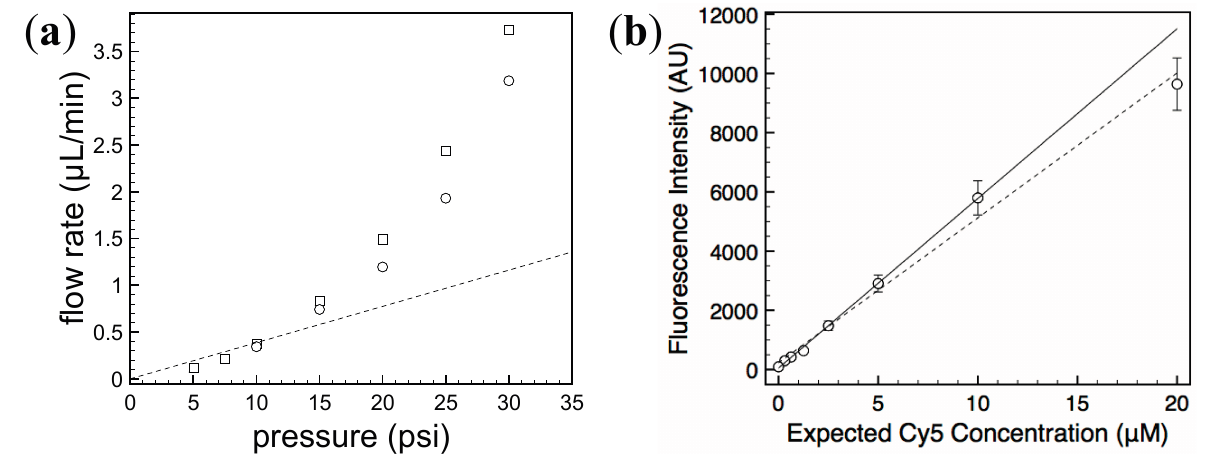
Figure 2. ( a ) Flow rates achieved by different injection methods: pressure controller ( □ ) and syringe compression ( ○ ). The microchannel used for this measurement had a dimension of 24 mm × 70 μ m × 7 μ m ( L × W × H ). The dashed line stands for the linear relationship between flow rate ( Q ) and injection pressure ( Δ P ) expected for a rectangular channel without any deformation: ∆ P = 12 μ QLH − 3 W − 1 , where μ is the fluid viscosity of water (assumed to be 0.001 Pa s). The fluidic resistance for the tested channel is 29 psi min μ L − 1 . The deviation from the linearity results from deformation of the PDMS channel [20]; ( b ) Fluorescence intensity measured from each culture chamber after injecting 20 μ M Cy5 solution. The error bars stand for standard deviations calculated from 100 × 100 pixel areas. The linear regression analysis of all 8 data points resulted in y = 489.22 x + 232.17 ( R 2 = 0.991; dashed line). The same analysis without the point at the highest concentration produced y = 572.71 x + 51.44 ( R 2 = 0.999; solid